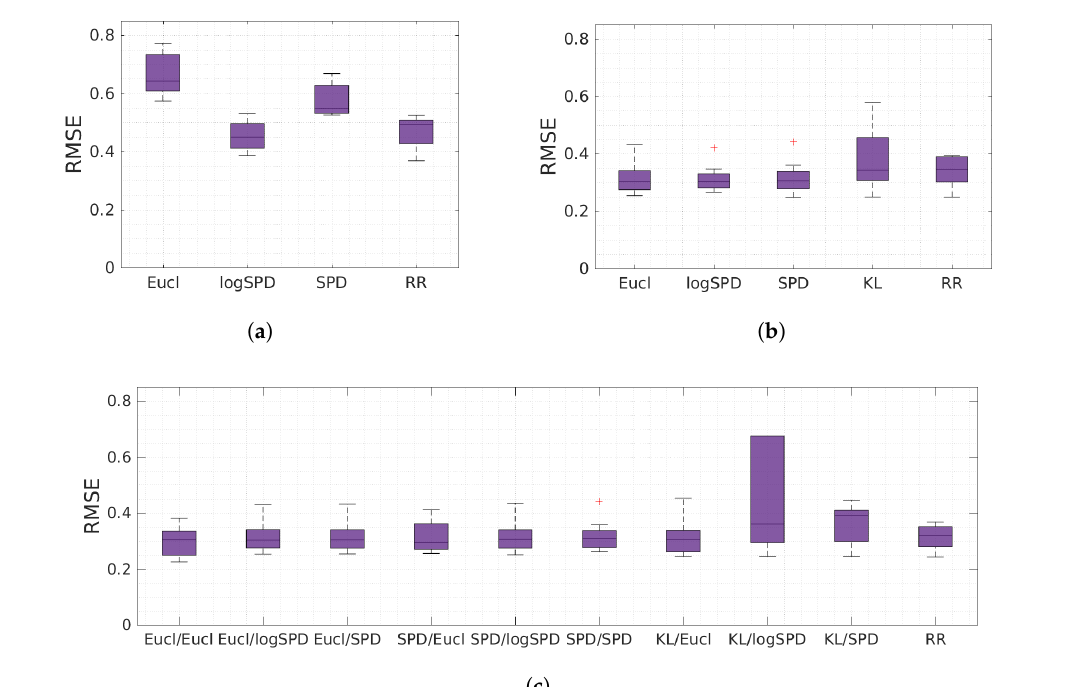
Figure 10. Performance of ridge regression (RR) and Gaussian process regression (GPR) with different distances using surface electromyography (sEMG) ( a ), tactile myography (TMG) ( b ), or both ( c ) as input for the regression